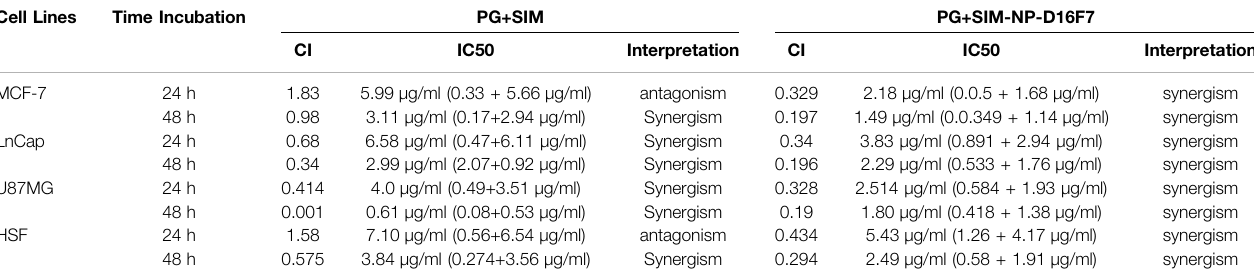
TABLE2| Comparison ofCIvaluesandtheirCIinterpretation forthecombinationoffreePG+SIMandthePG+SIM-NPsafter 24and48 hincubationondifferentcelllines. Cell